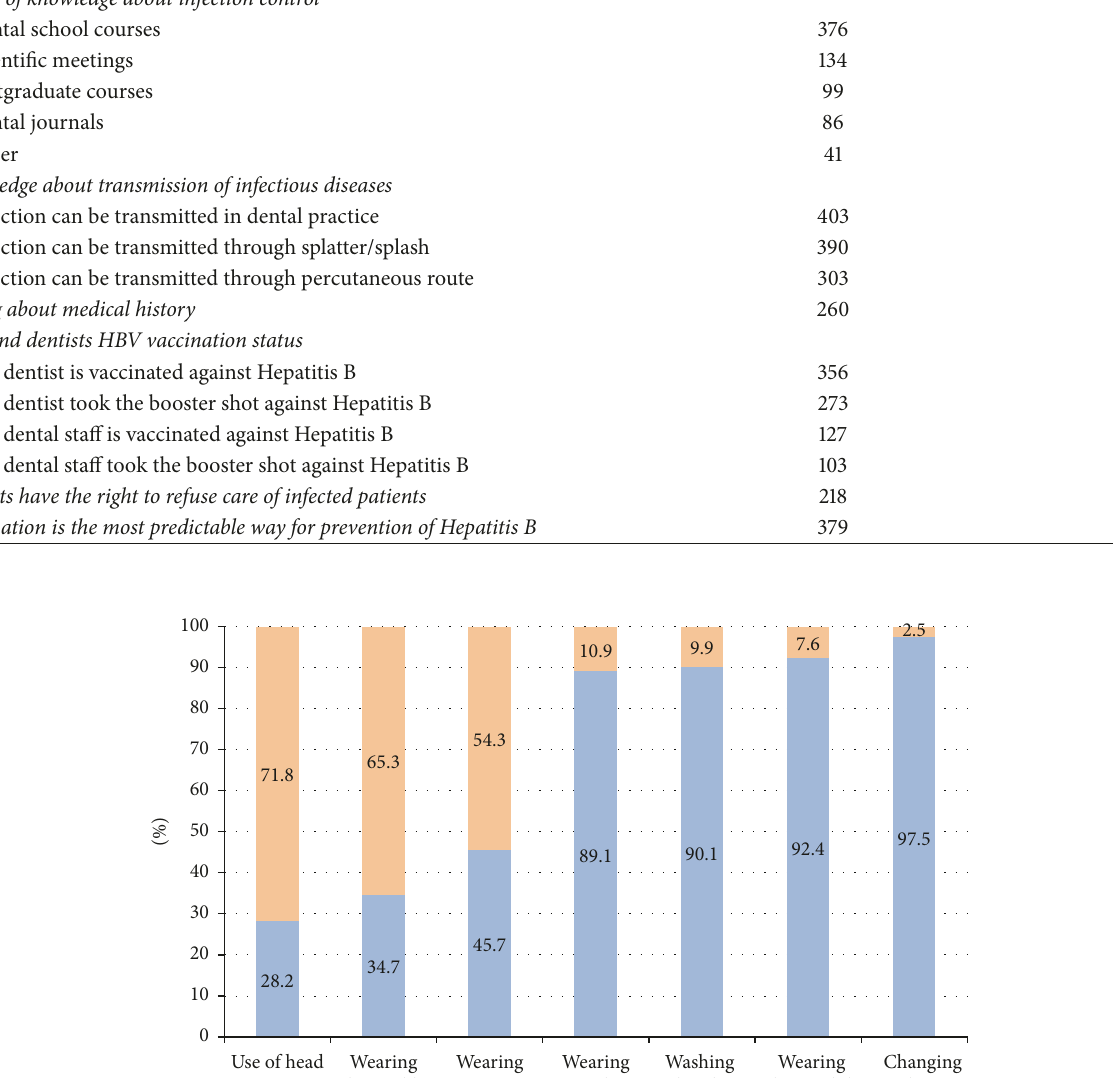
Table 2: Knowledge, attitude, and behavior of dentists relative to infectious diseases in private dental clinics in Lebanon (2015). Questions related to infectious diseases